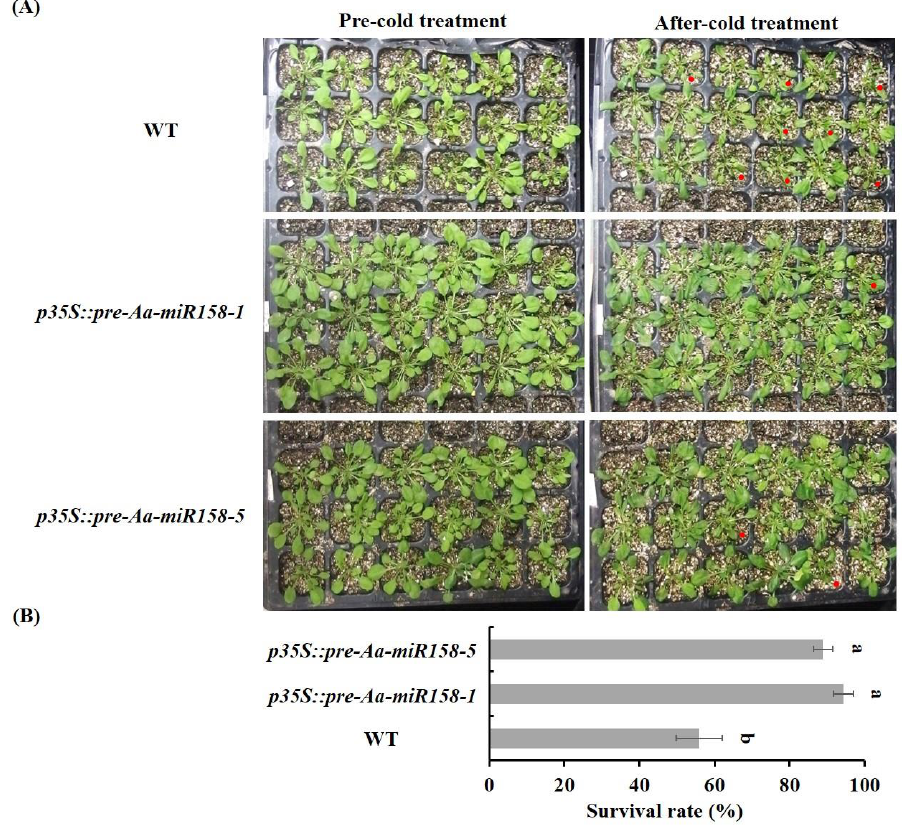
Figure 5. Comparative analyses of Aa-miR158 transgenic ( p35S::pre-Aa-miR158 -1 and p35S::pre-Aa- miR158 -5) and wild-type (WT) Arabidopsis plants under cold stress. ( A ) Phenotype of Aa-miR158 transgenic and WT Arabidopsis plants. Red dots indicate severely damaged plants. ( B ) Survival rates after cold stress treatment for 24 h. Error bars represent standard deviations ( n = 3). Values marked with the different letter are significantly different ( p < 0.05, Student’s t -test).